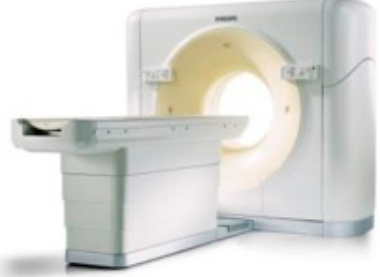
Figure 4. X-ray computed tomography (CT) room.